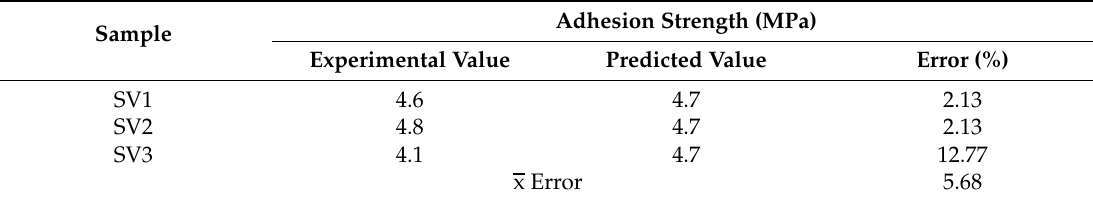
Table 7. Experimental validation for adhesion strength.